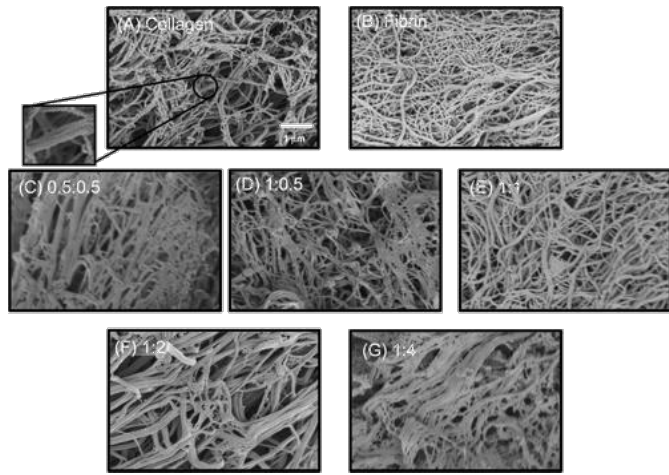
Figure 6. SEM images of pure collagen, pure fibrin and mixed hydrogels at various collagen:fibrin ratio prepared by protocol (1′). Reprinted with permission from [124]. Copyright 2006 American Chemical Society.